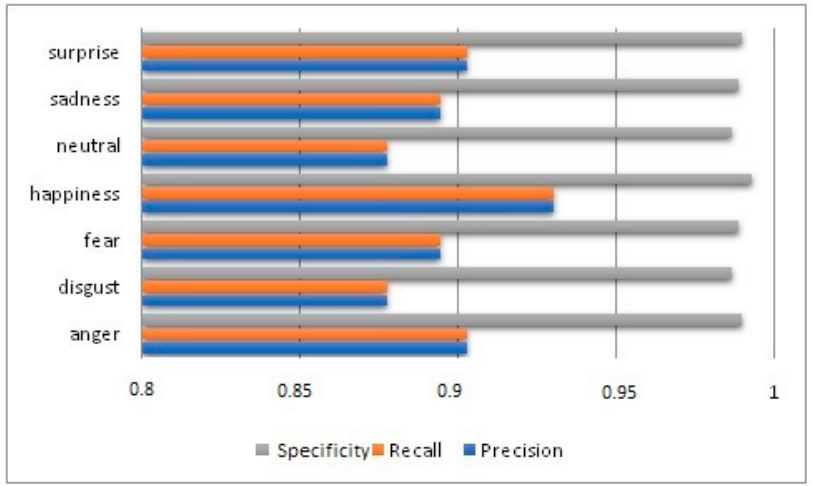
Figure 6. Emotion classification